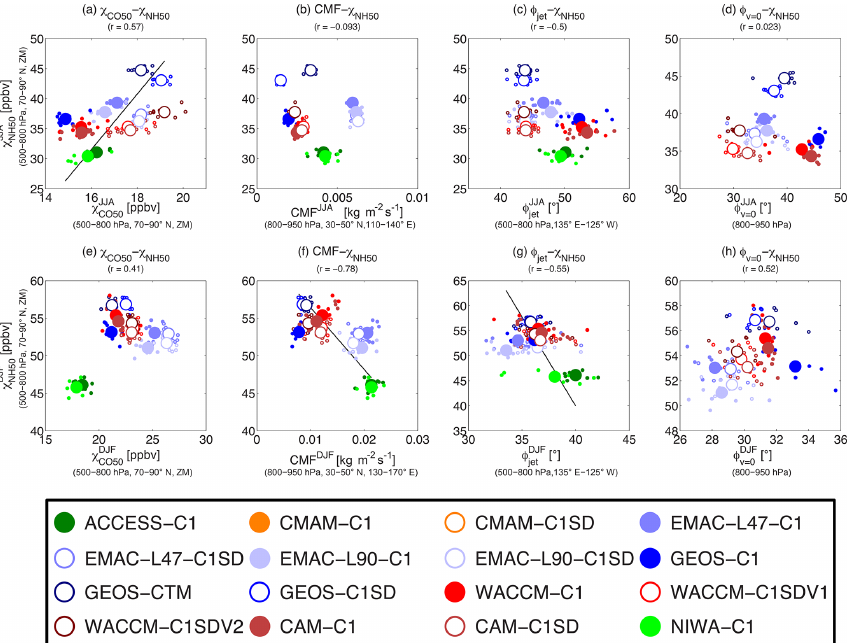
Figure 12. (a, e) Tracer–tracer correlation between NH50 and CO50 over the Arctic (500–800hPa, 70–90 ◦ N, ZM), (b, f) as in Fig. 3, (c, g) as in Fig. 6, and (d, h) as in Fig. 10b, e, except the y axis is replaced as the Arctic NH50 concentration. Results for JJA are shown in (a) – (d) , while those for DJF are shown in (e) – (h)